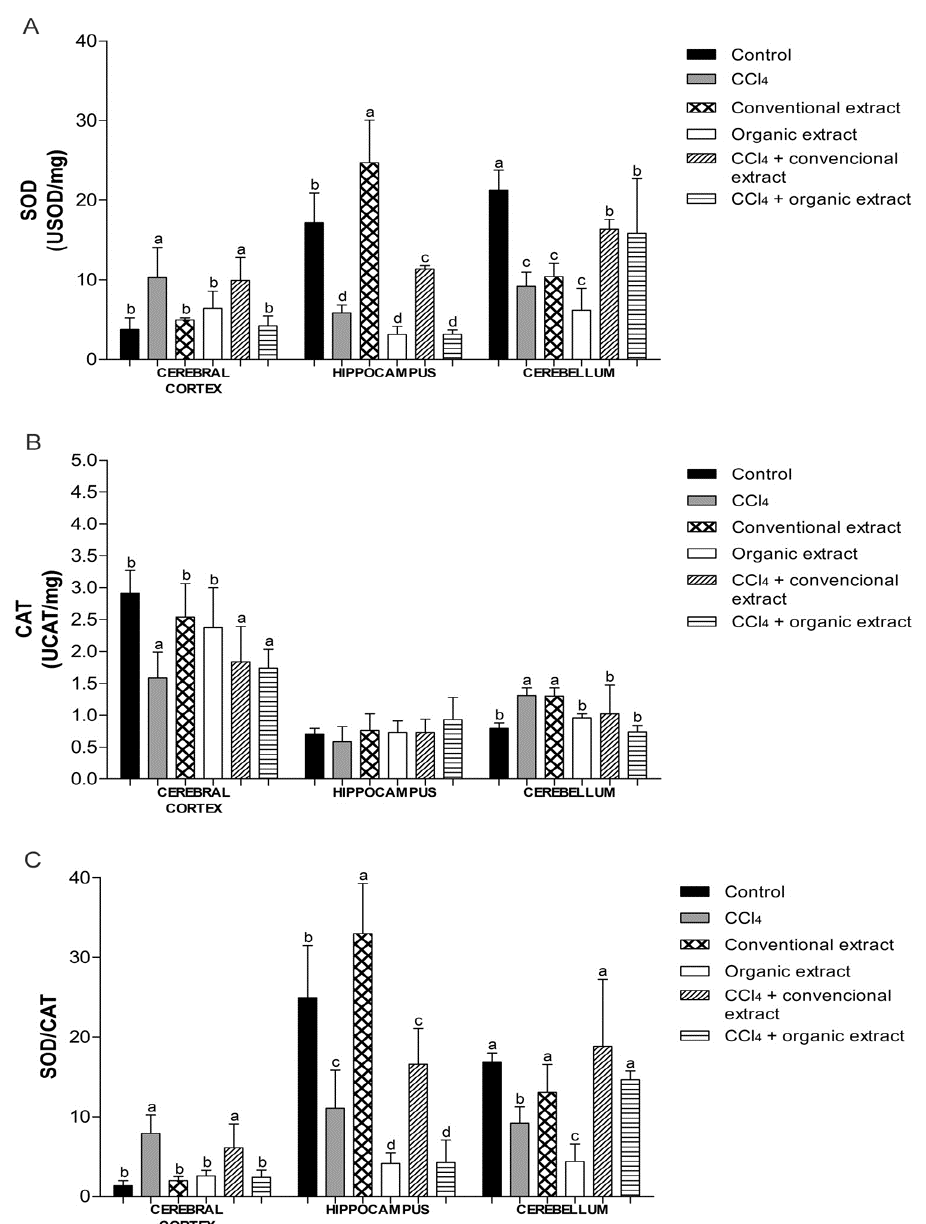
Figure 2. ( A ) Superoxide dismutase (SOD) activity (USOD/mg protein) ( B ) Catalase (CAT) activity (UCAT/mg protein) and ( C ) SOD/CAT ratio in brain tissues of rats treated with different extracts (organic and conventional) and carbon tetrachloride (3 mL/kg). Data are expressed as mean ± SD. Different letters indicate statistical difference according to ANOVA and Tukey’s post-test ( p < 0.05) for each tissue